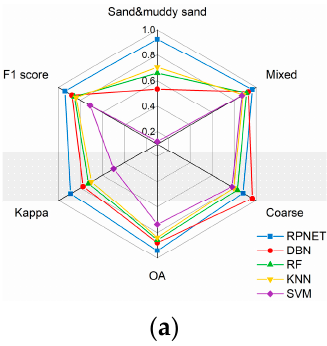
( c ) Figure 16. Comparison of different classifiers when the number of training samples decrease in S2. ( a ) Training: test = 7:3; ( b ) training: test = 6:4; ( c ) training: test = 5:5. The proposed decision fusion method takes advantage of the merits of the two clas- sifiers and overcomes their individual shortcomings, thus demonstrating better perfor- mance than any classifier alone. As can be observed from the Tables 5 and 6, the classifi- cation accuracy of a single shallow learning classifier is low for classes that are relatively